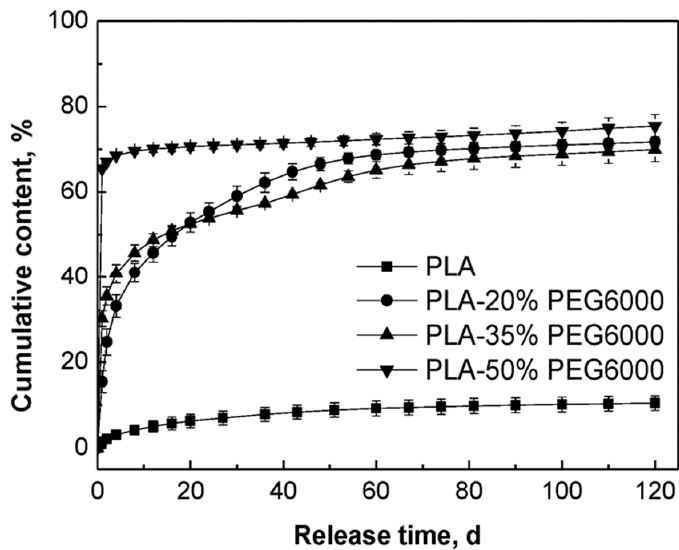
Figure 4. E ff ect of content of PEG on the in-vitro release behavior of MB from the PLA / PEG blends Figure 4. Effect of content of PEG on the in-vitro release behavior of MB from the PLA/PEG blends without ultrasound without ultrasound treatment.